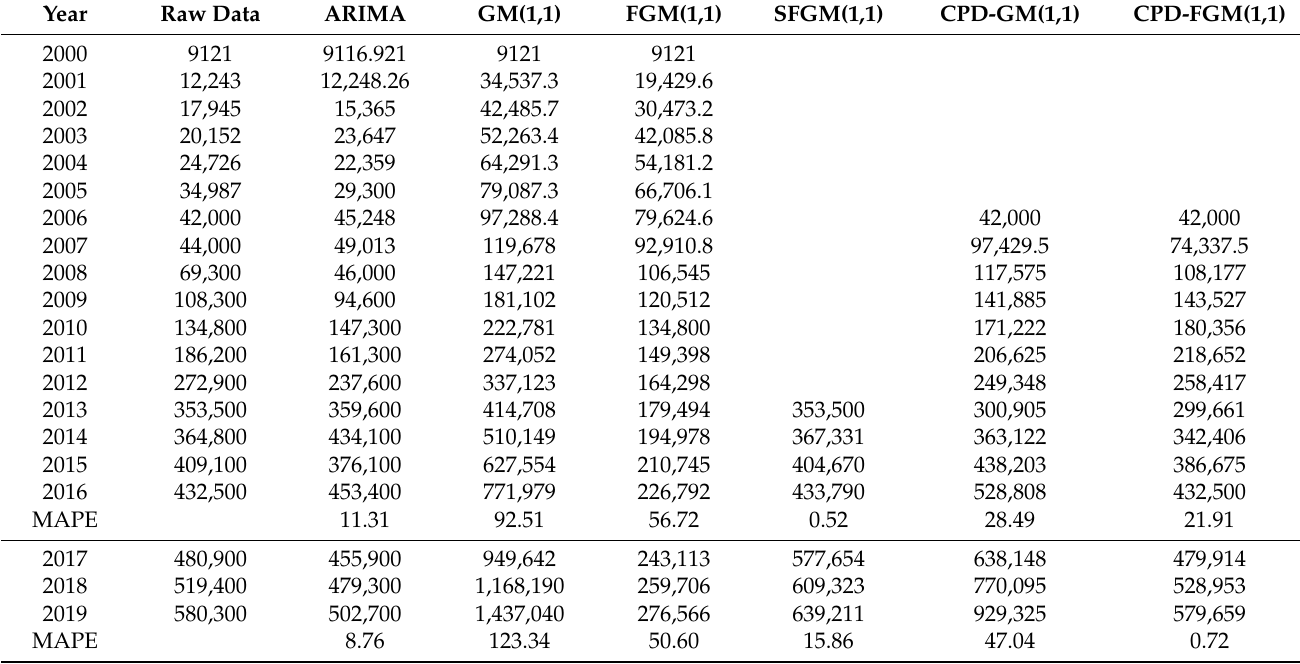
Table 3. Results for returned students